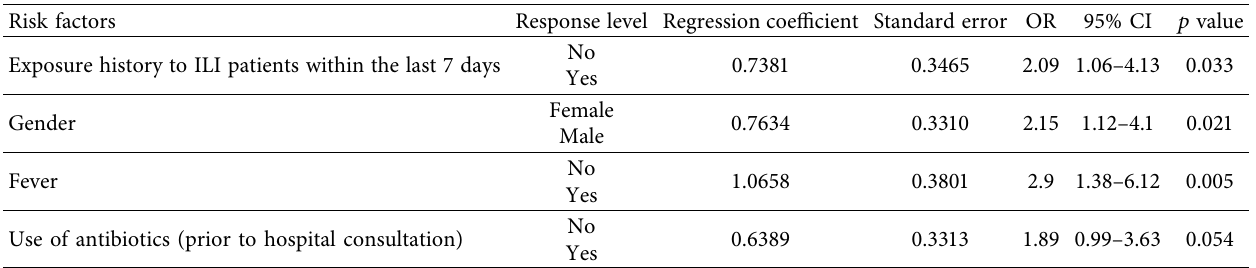
Table 2: Multivariable analysis of risk factors/risk markers for IAV among ILI and SARI cases during hospital-based surveillance. Risk factors Exposure history to ILI patients within the last 7